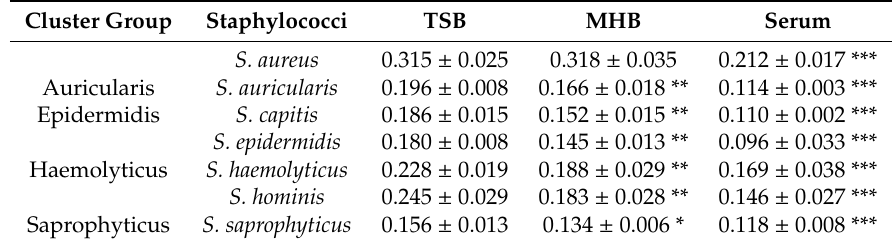
Table 5. Membrane fluidity (anisotropy values 1 ) of the coagulase-negative staphylococcal